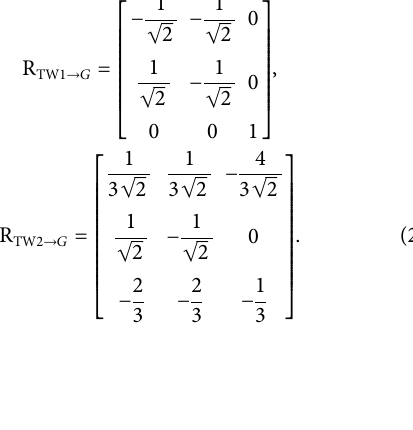
a θ of the 3 / 1 and orientation angle